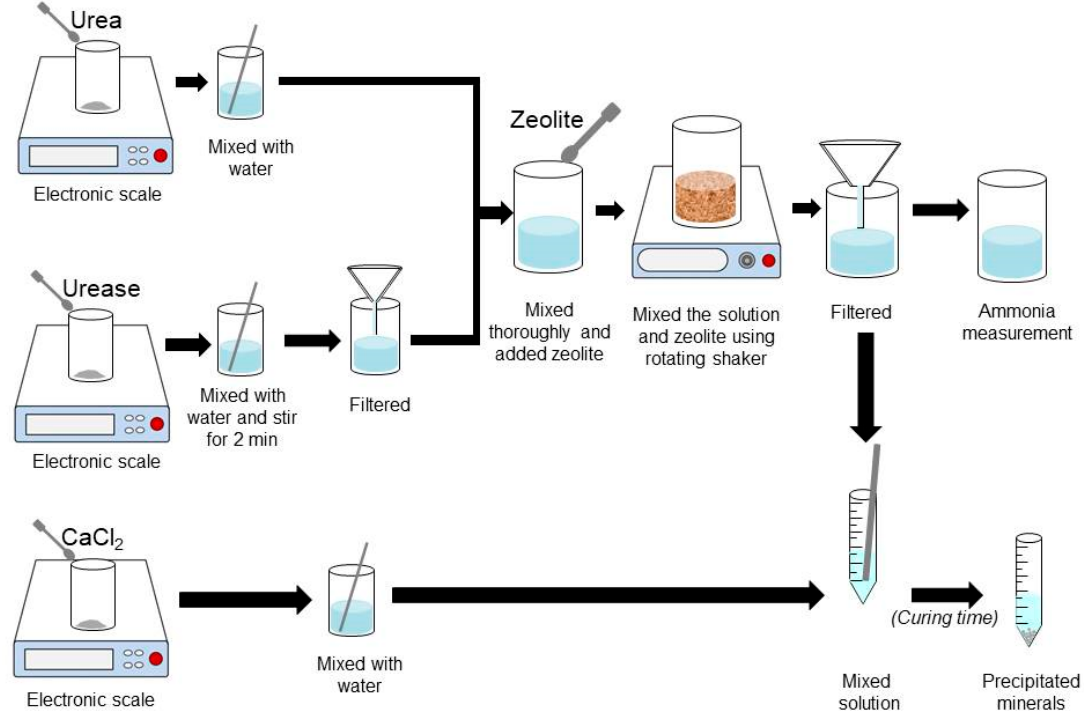
Figure 4. Procedure for sample preparation for NH-forms measurement and precipitation tests.